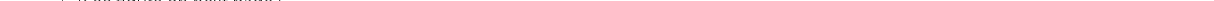
circulation(See figure on next Fig. 3 A 1‑month‑old male patient presented with poor feeding and dyspnea. a MDCT VR oblique anterior view showed PDA arising from inferior surface of the aorta connected to MPA, b VR oposterior view showed PDA connected to dilated MPA, c VR oblique posterior view showed hypoplastic aortic arch with focal coarctation seen at the aortic isthmus, d VR oblique posterior view showed normal branching pattern of the aorta, e axial MIP view showed pulmonary end of PDA and also persistent left SVC is seen, f Sagittal MIP image showed type C (tubular) PDA connecting between MPA and inferior surface of aortic arch, g Coronal MIP image showed focal aortic isthmus coarctation with hypoplastic aortic arch, h Short axis view showed dilated right ventricle, i Coronal MIP image showed normal pulmonary venous return. A case of aortic coarctation with duct dependent systemic